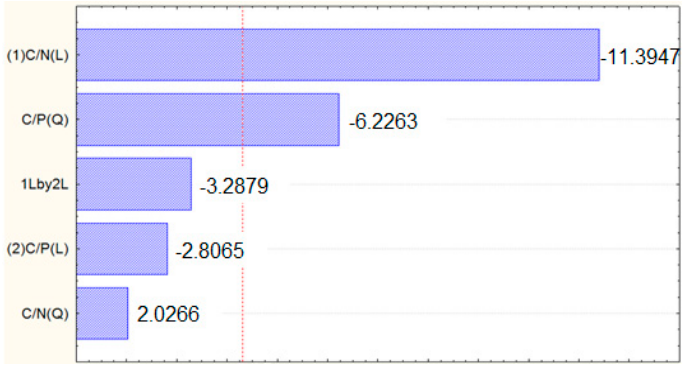
per dry cell mass.